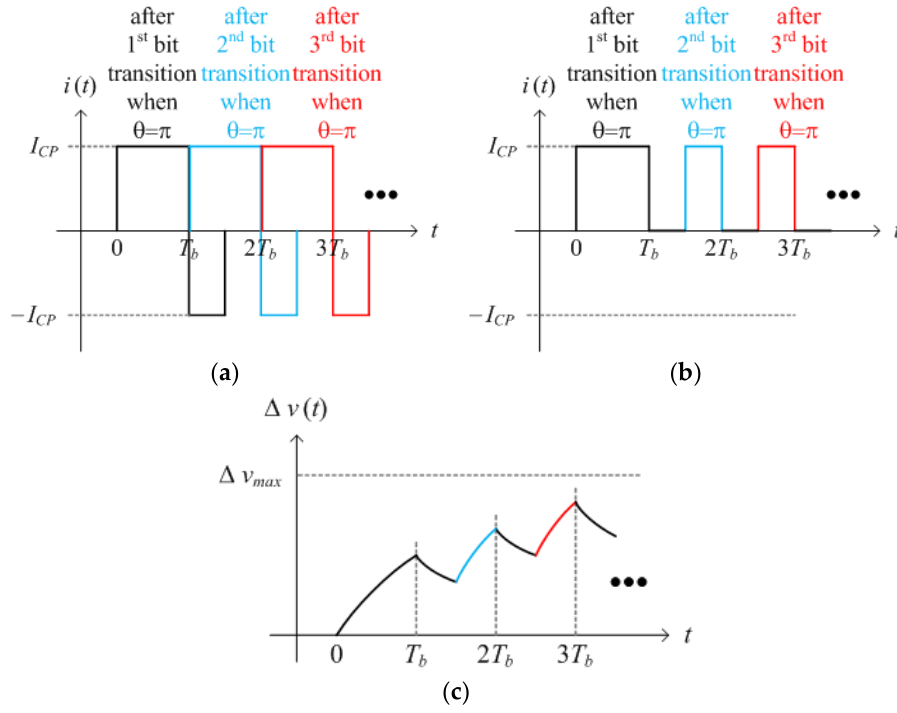
Figure 8. ( a ) Each and ( b ) the effective real-time charge pump current after consecutive bit transitions when θ = π and ( c ) the consequent ripple voltage.